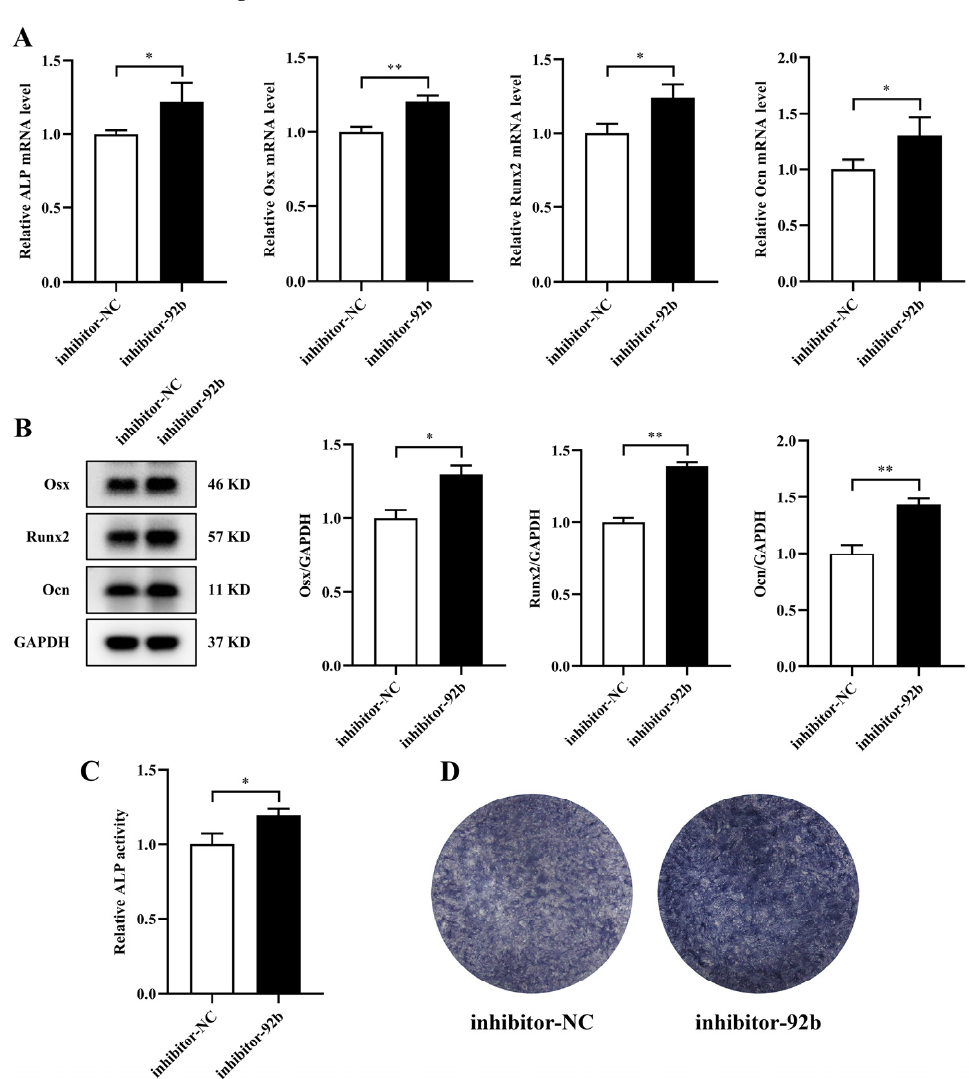
Figure 5. Exosomes derived from MVECs cultured under mechanical unloading inhibit osteogenic differentiation by transferring miR-92b-3p. miR-92b-3p inhibitor and NC-inhibitor were transfected into Clino Exos via electroporation. ( A ) mRNA expression levels of ALP, Osx, Runx2, and Ocn in MC3T3-E1 cells treated with Clino Exos (electroporated with miR-92b-3p inhibitor/NC-inhibitor, 200 µ g/mL) ( n = 3). ( B ) Protein levels of Osx, Runx2, and Ocn in MC3T3-E1 cells treated the same as above ( n = 3). ( C ) Relative ALP activity analysis in MC3T3-E1 cells treated the same as above ( n = 3). ( D ) Representative staining images for ALP in MC3T3-E1 cells treated the same as above after 7 days osteogenic induction ( n = 3). * p < 0.05, ** p < 0.01 vs. control.